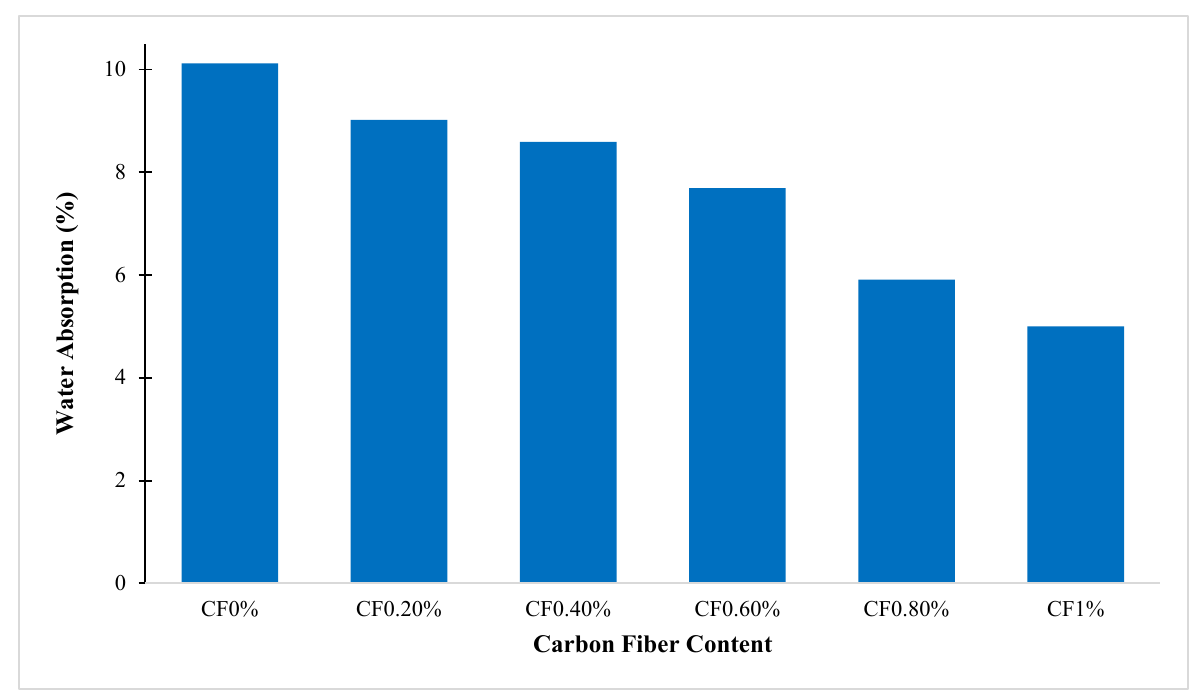
Figure 9. Water absorption.